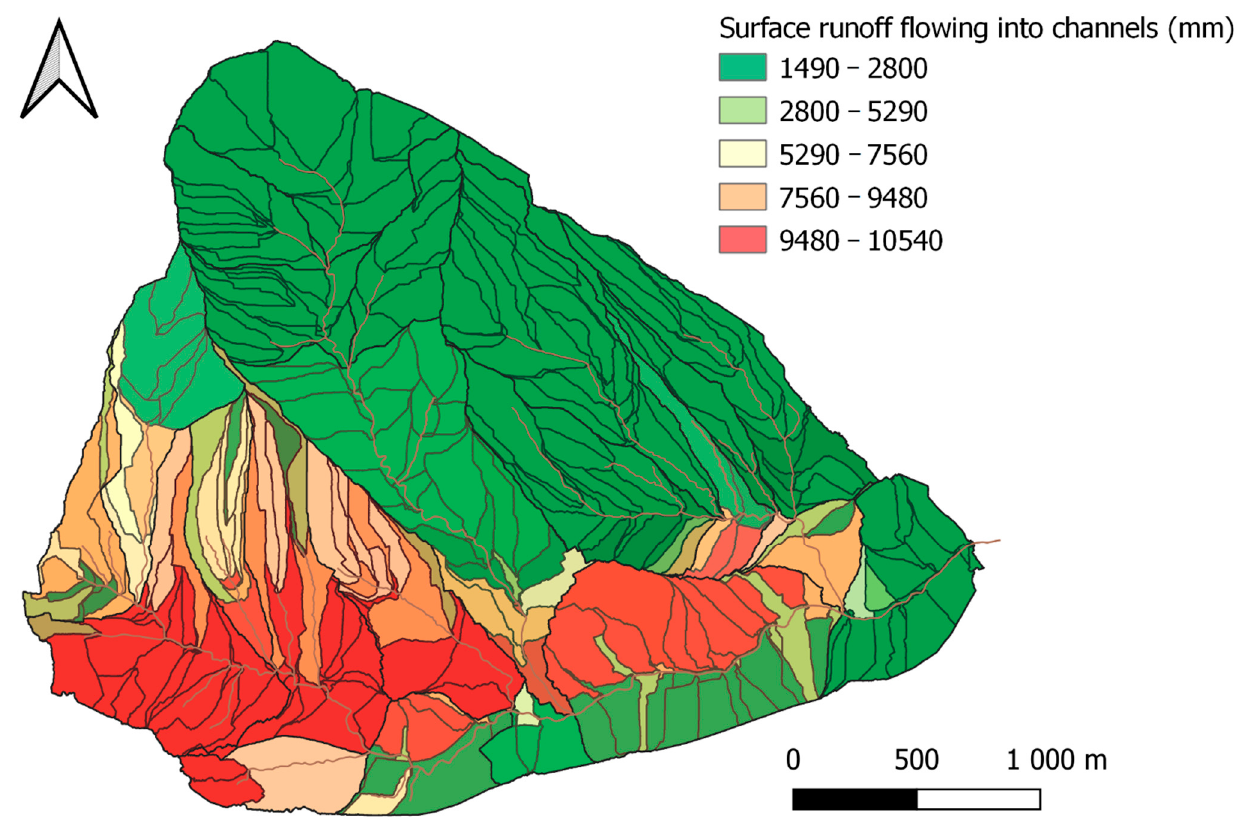
Figure 5. Surface runoff for Smugawka catchment in simulation period 1991–2020.